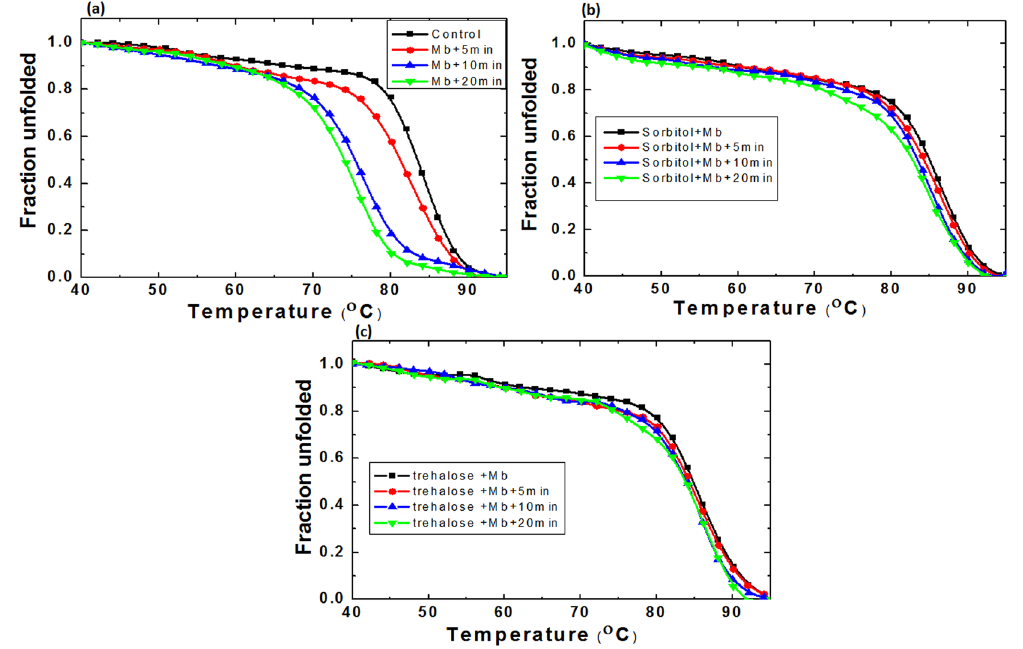
Figure 2. Thermal denaturation profile of Myoglobin protein after treatment with DBD plasma for different time intervals such as 20, 10 and 5 min ( a ) control Myoglobin, ( b ) Myoglobin + sorbitol and ( c ) +